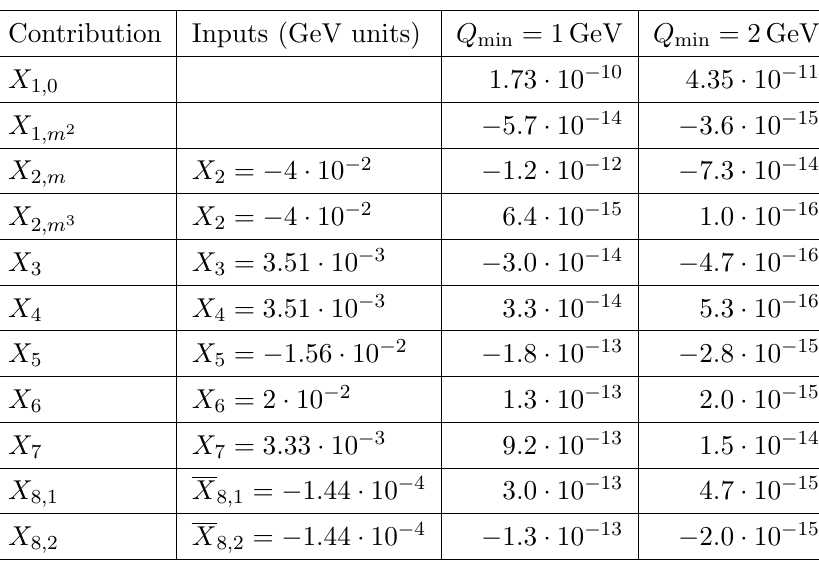
Table 1 . Numerical results for a HLbL